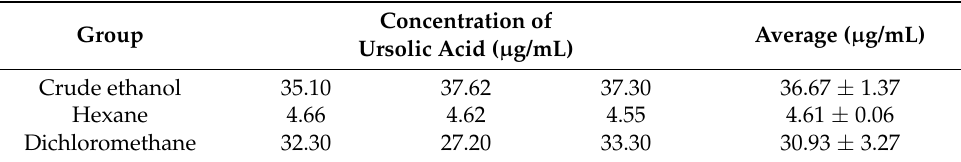
Table 1. The concentration of ursolic acid in each extract and fractions.